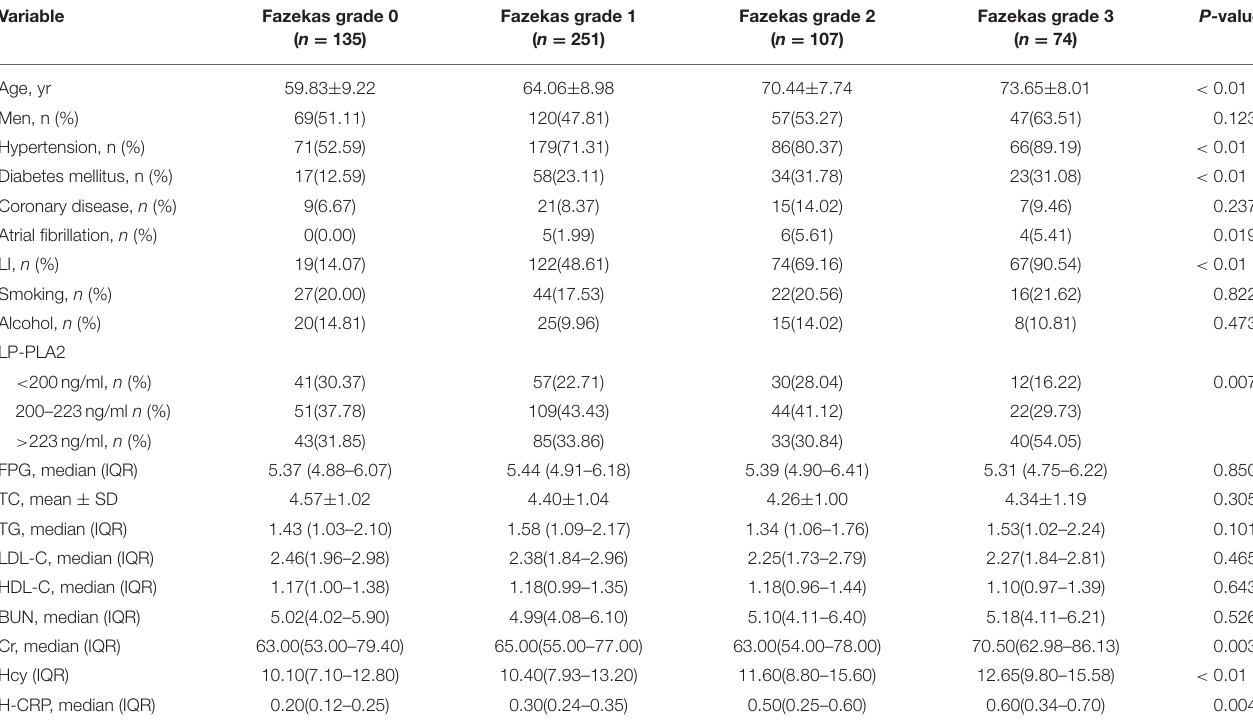
TABLE 2 | Clinical characteristics of subjects with